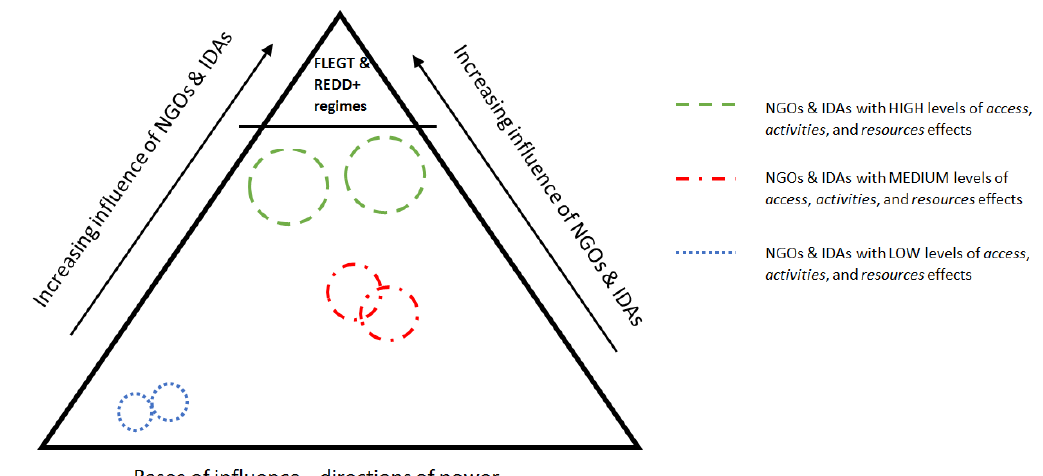
Figure 1. A map of Nongovernmental Organizations (NGOS) and International Development Agencies (IDAs) capability to influence Forest Law Enforcement, Governance and Trade agreement (FLEGT) and Reducing Emissions from Deforestation and Forest Degradation (REDD+) regimes outcomes. Source: Author’s elaboration . Note: The more the activities, access opportunities, and